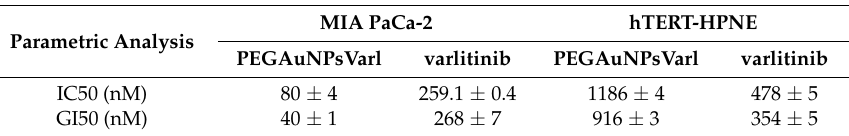
Figure 6. Confocal reflectance images of the hTERT-HPNE cells after 48 h incubation: ( a ) control untreated cells; ( b ) 0.5 nM of PEGAuNPs; ( c ) 0.5 nM of PEGAuNPsVarl. Scale bar in all images is 10 µ M. Table 3. Half maximal inhibitory concentration (IC50) and effect of varlitinib alone and PEGAuNPsVarl on the growth inhibition (GI50) on the pancreatic cell lines—MIA PaCa-2 and hTERT- HPNE.